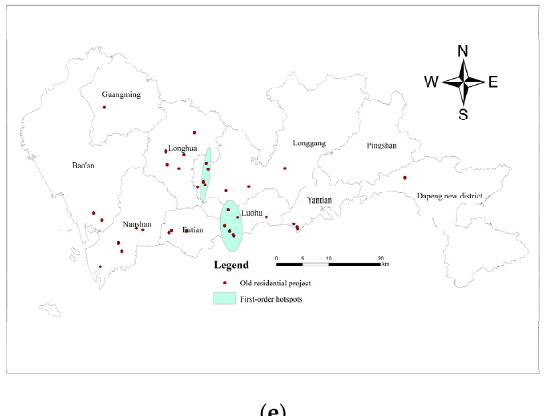
Figure A2. Spatial Distribution of UR Hotspot Cluster Areas: ( a ) all UR projects; ( b ) urban village projects; ( c ) old industrial projects; ( d ) old commercial projects; and ( e ) old residential projects.